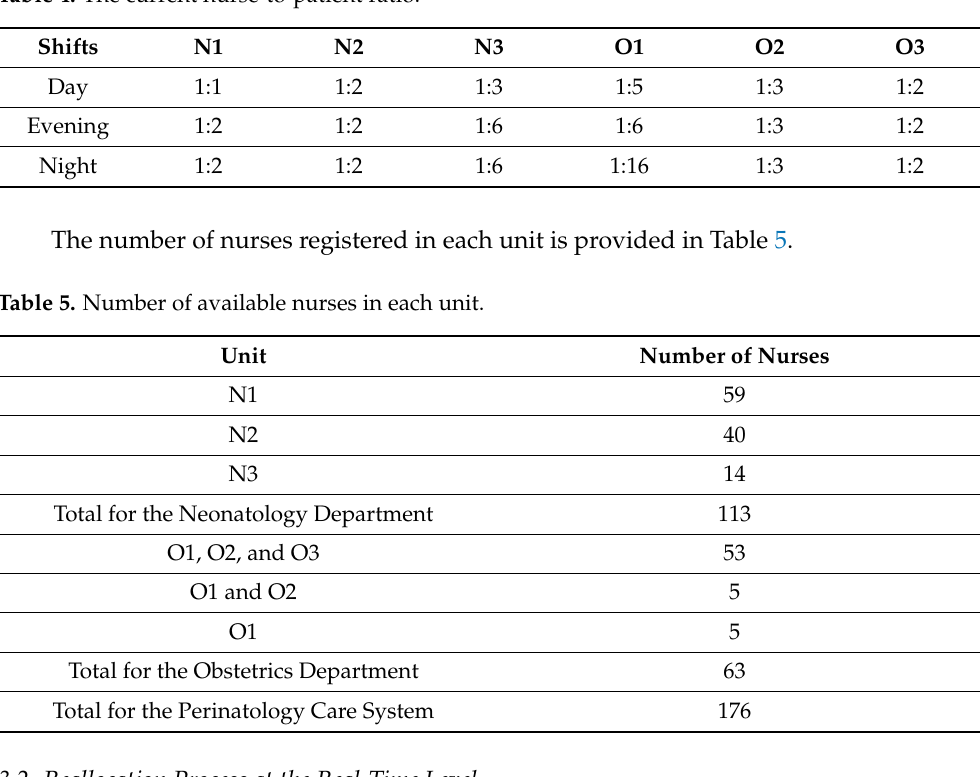
Table 4. The current nurse-to-patient ratio.